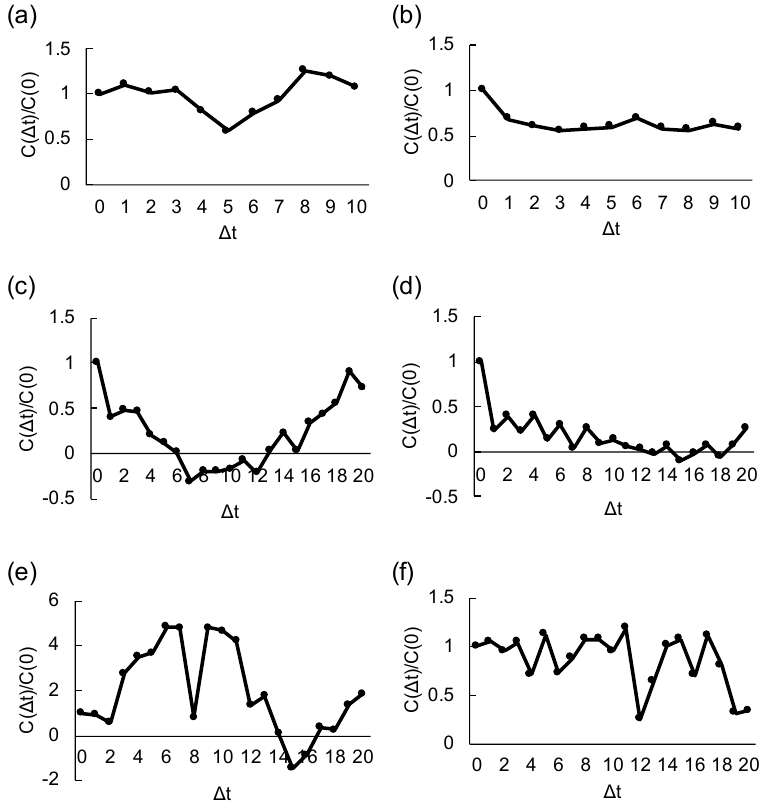
Figure 9. The velocity auto-correlation of cells in the microchannels. ( a – d ) Auto-correlation of the velocities of cells traced in 10µm (see Figure 6), 58µm (Figure 7a), 135µm (Figure 7b), and 211µm width channels (Figure 7c), respectively. ( e , f ) Cross-correlation of two cells in each of 135µm (Figure 7b), and 211µm (Figure 7b) channels, respectively. The auto- and cross-correlation values C(dt) were normalized by